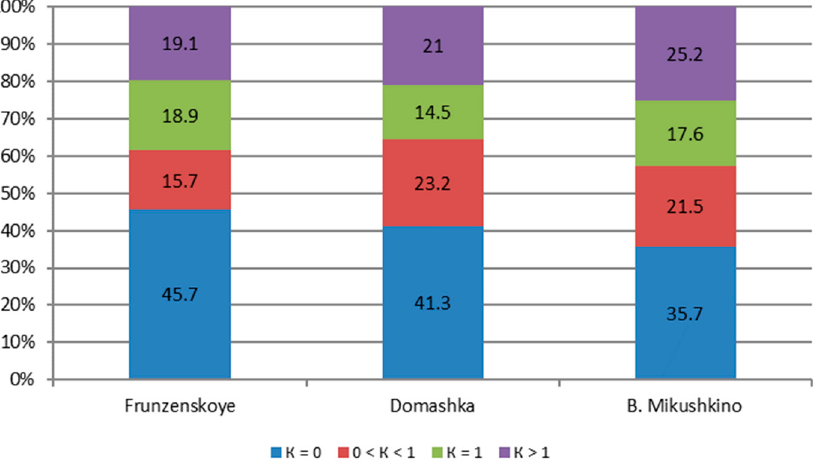
Figure 12. Comparison of private household plots in relation to the number of employed and unemployed members in 2014–2018.